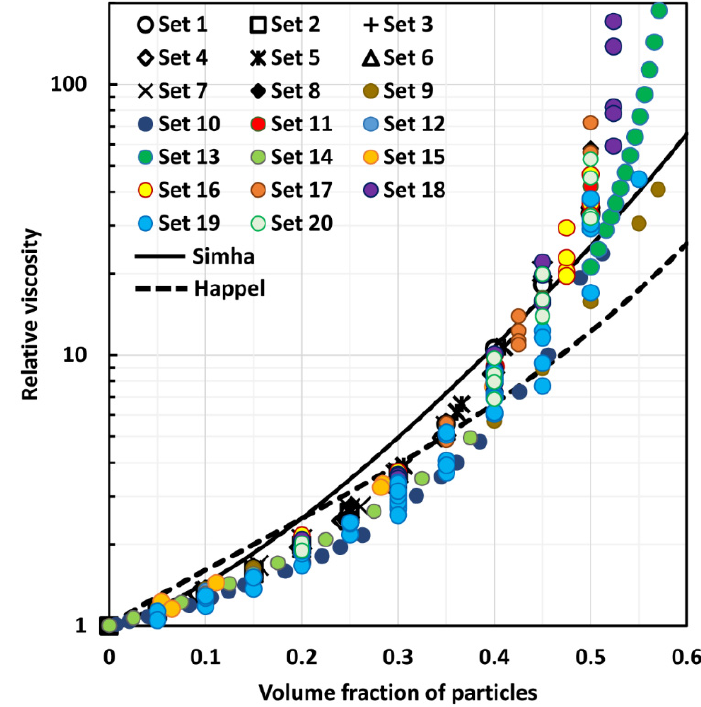
Figure 8. Comparison of experimental viscosity data for suspensions of non-Brownian hard spheres with the predictions of Simha and Happel models.